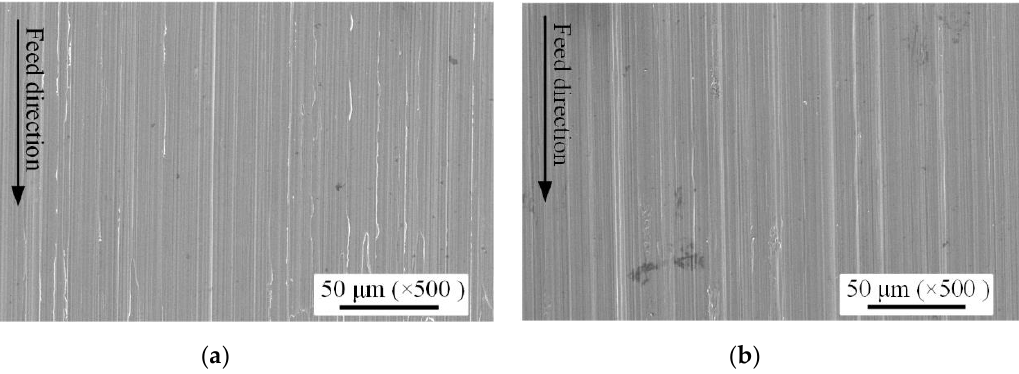
Figure 5. Surface topography after different cooling conditions. ( a ) Surface topography of wet milling, ( b ) Surface topography of dry milling.